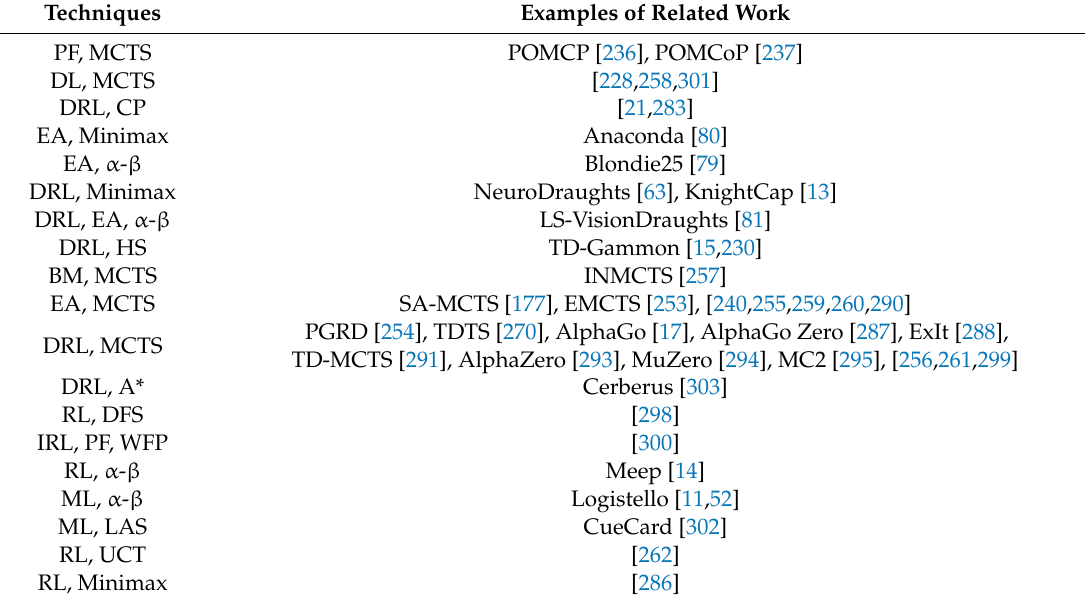
Table 5. Combinations of planning and learning techniques and examples of related work. In the table the following terms were abbreviated as: classical planning (CP), Alpha-Beta ( α - β ), depth-first search (DFS), Bayesian model (BM), heuristic search (HS), look-ahead search (LAS), and Wavefront Planner